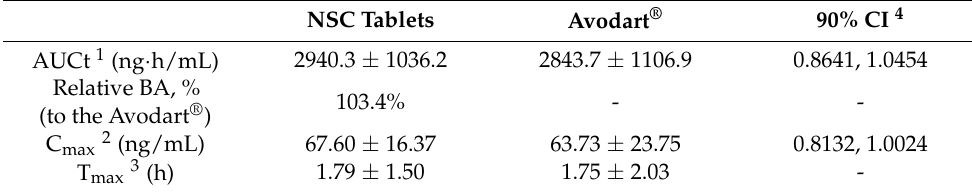
Figure 7. Plasma concentration–time profiles of dutasteride (0.5 mg) after a single oral administration of NSC tablets and Avodart ® soft capsules in beagle dogs ( n = 12). Table 5. Pharmacokinetic parameters of dutasteride after a single oral administration of NSC tablets and Avodart ® soft capsules in beagle dogs. All data are expressed as mean ± standard deviation (S D), n = 12.